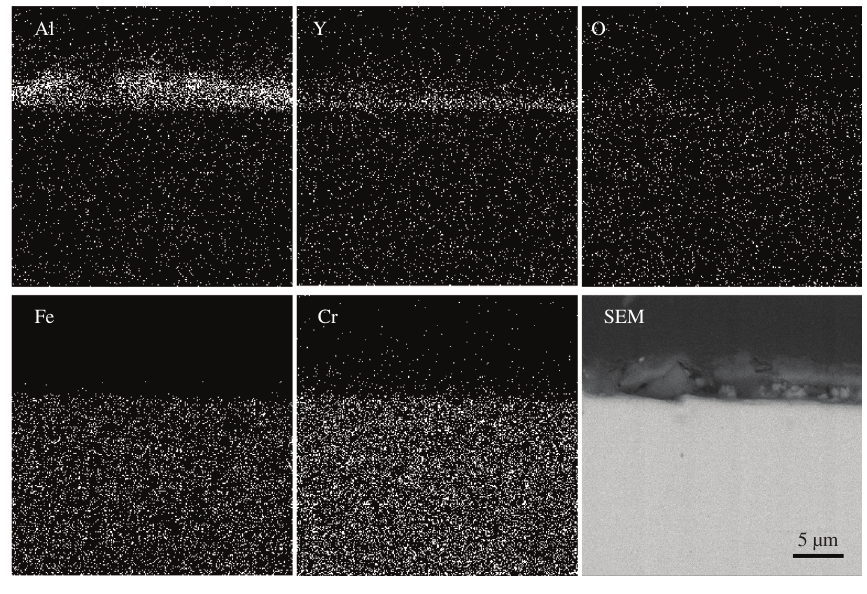
Figure 2: EDX pattern and cross-sectional morphology of the pre-oxidized AlY coating.